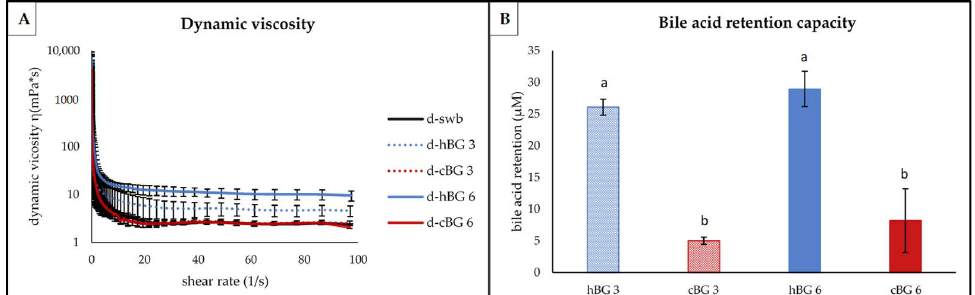
Figure 6. Functional properties of chyme from digested breads fortified with 3% of high molar mass β -glucan (BG) or control BG (d-hBG 3 or d-cBG 3) and 6% of high molar mass BG or control BG (d-hBG 6 or d-cBG 6) presented as: ( A ) dynamic viscosity; ( B ) bile acid retention capacity. All values are shown as mean ± standard deviation ( n = 3, p < 0.05). Different lower-case letters indicate a significant difference between the chyme samples.